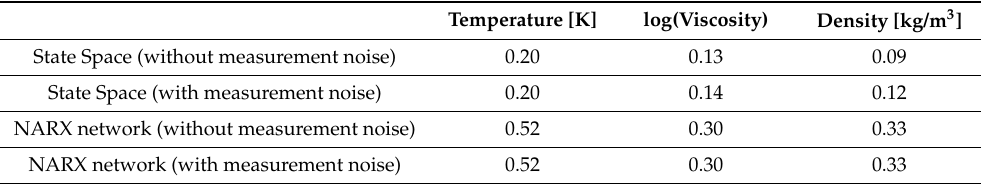
Table 3. Mean NRMSE evaluations for the validation of the identified models against distinctly generated input